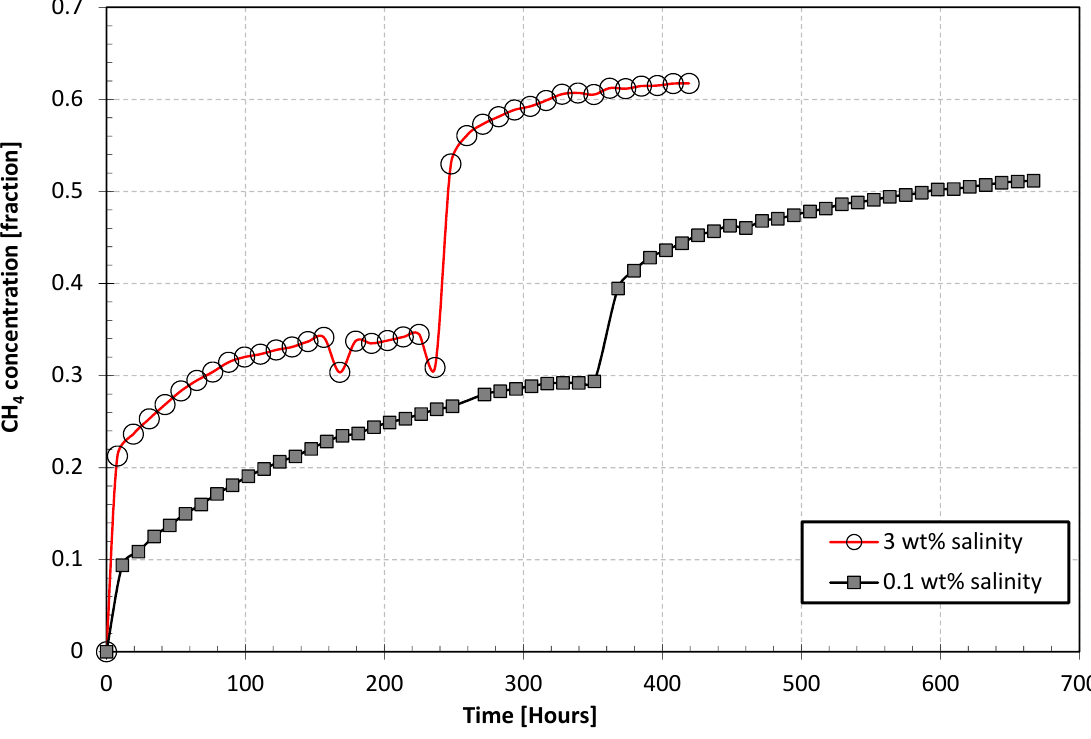
Figure 7. CH 4 accumulation in the spacer volume was more significant for the higher salinity experiment (red line, open black circles), which suggests that there may be an effect of elevated salinity on the CH 4